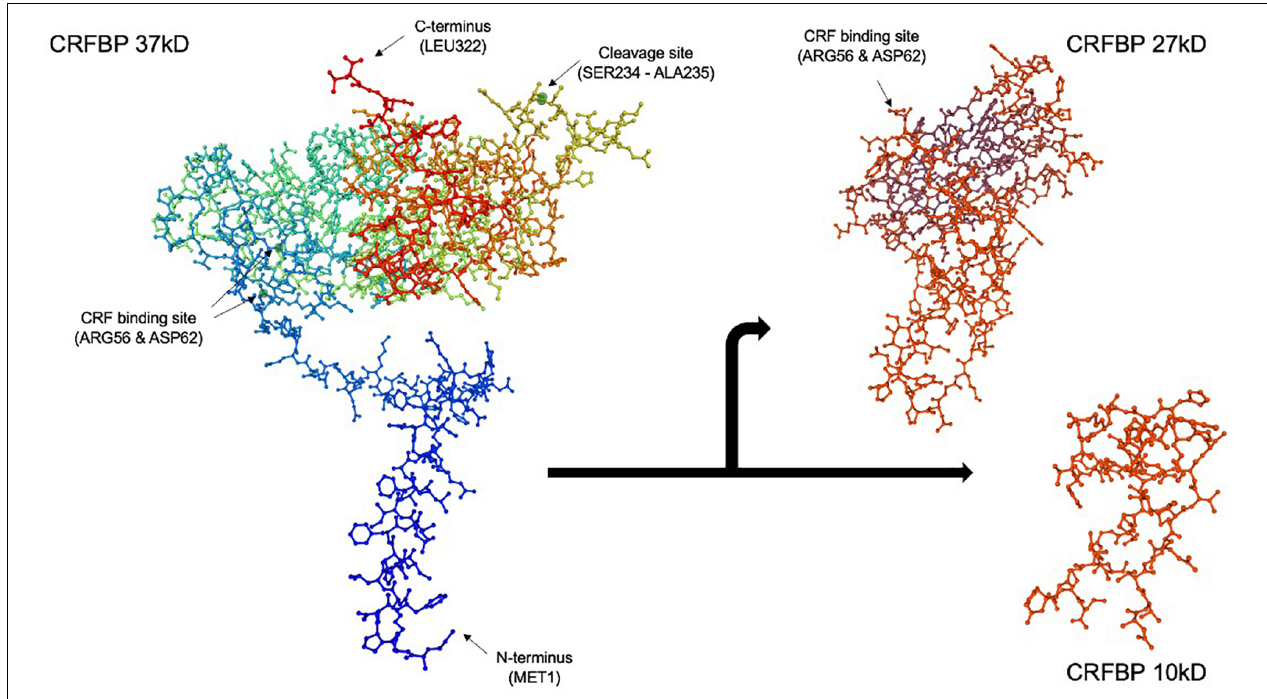
FIGURE 1 | Corticotropin releasing factor binding protein (CRFBP) 37 kD model by SWISS-MODEL protein structure homology. CRFBP is composed of 322 amino acid residues, spanning from the N-terminus at methionine 1 (MET1) to the C-terminus at leucine 322 (LEU322). Spontaneous, proteolytic cleavage occurs between amino acid residues serine 234 (SER234) and alanine 235 (ALA235), resulting in formation of the 27 kD N-terminal and 10 kD C-terminal fragments. The high affinity, CRF selective binding sites located at arginine 56 (ARG56) and aspartic acid 62 (ASP62) are retained by the 27 kD fragment. The 27 kD fragment, which acts as a scavenger of excess CRF, is believed to be responsible for the inhibitory role of CRFBP. Conversely, studies indicate the 10 kD fragment may possess excitatory functions through its selective interaction with CRFR 2 . The full 322 amino acid CRFBP (37 kD), N-terminal fragment (27 kD) (reduced amino acid sequence 62-212), and C-terminal fragment (10 kD) (reduced amino acid sequence 45–85) figures were computed using SWISS-MODEL (Guex et al., 2009; Bienert et al., 2017; Waterhouse et al.,